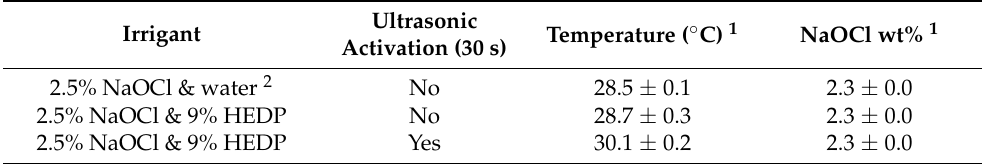
Table 1. Amount of available chlorine as determined by iodometric titration when room-temperature (23 ◦ C) irrigants were placed in the ultrasonic water bath (38 ◦ C, 37 kHz) and were then activated or left non-activated for 30